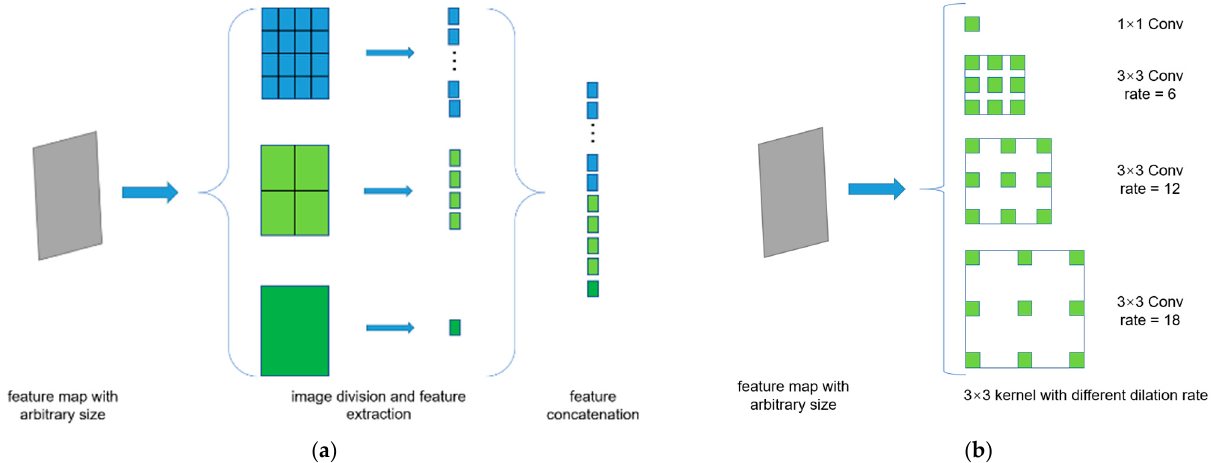
Figure 2. Illustration of ( a ) spatial pyramid pooling (SPP) structure and ( b ) atrous spatial pyramid pooling (ASPP) structure in DeepLab v3+.